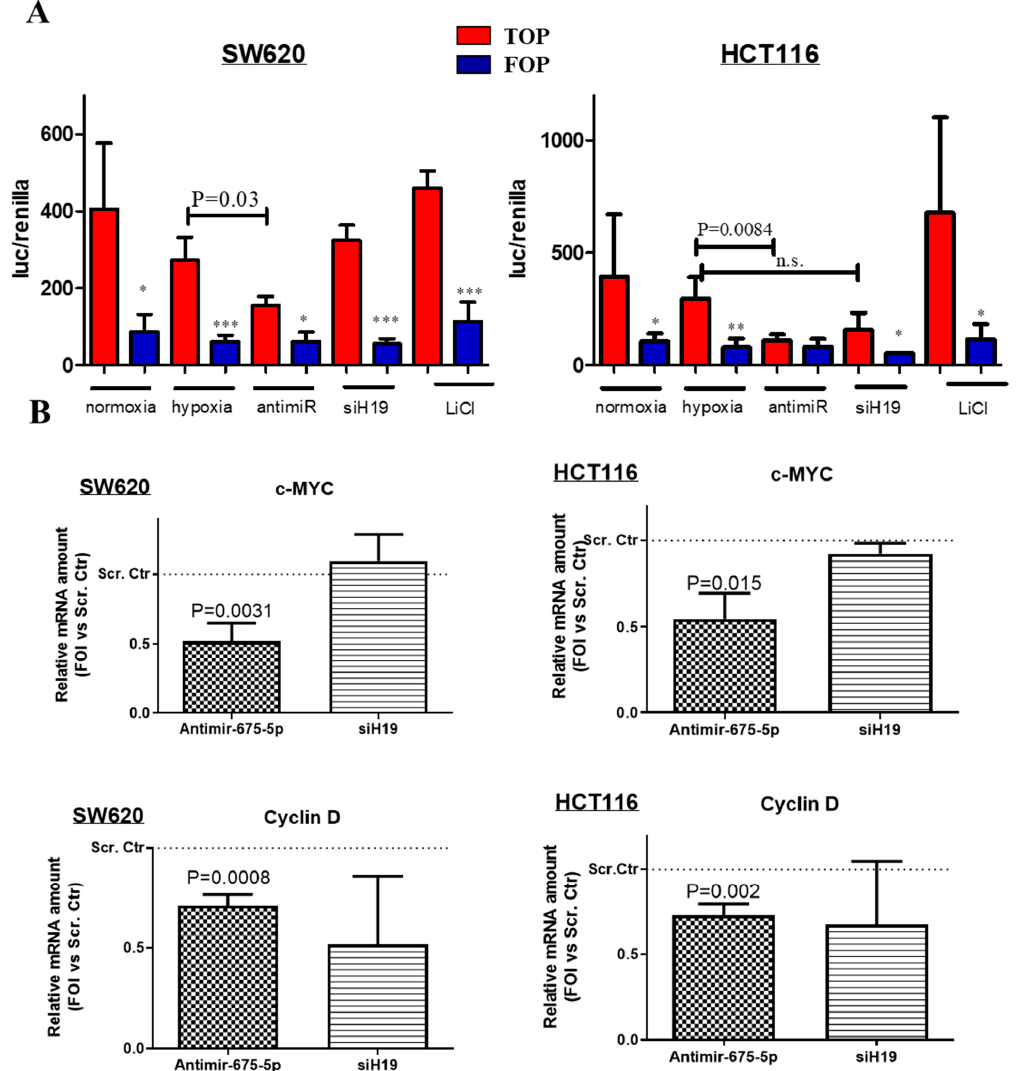
Figure 4. E ff ects induced on β -catenin activity by miR-675-5p inhibition or lncH19 silencing in hypoxic cells. ( A ) Dual Glo luciferase assay on SW620 (left graph) and HCT116 (right graph) transfected with TOP- Flash or FOP-Flash plasmid in normoxic condition or co-transfected with AntimiR-675-5p, siH19 or scrambled negative control, and subjected to 18 h of hypoxic stimulation. Normoxic cells transfected with TOP-Flash or FOP-Flash plasmid and treated with LiCl were used as positive control of the assay. Data are expressed as the mean ± SD of three independent experiments. The p -values of the di ff erences between TOP vectors are indicated in the graph, while the * indicates the p -values of the di ff erence between TOP and FOP for each condition. * < 0.05, ** < 0.005, *** < 0.0005. ( B ) Real-time PCR for c-MYC and Cyclin D1 in SW620 (left panels) and HCT116 (right panels) transfected with AntimiR-675-5p, siH19 or relative scrambled negative control and subjected to 18 h of hypoxic stimulation. Gene expression data were normalized for β -actin, ∆∆ ct is expressed as fold of increase (FOI) with respect to the expression in the scrambled negative control transfected cells. Data are expressed as the mean ± SD of three independent experiments and p -values are indicated in the